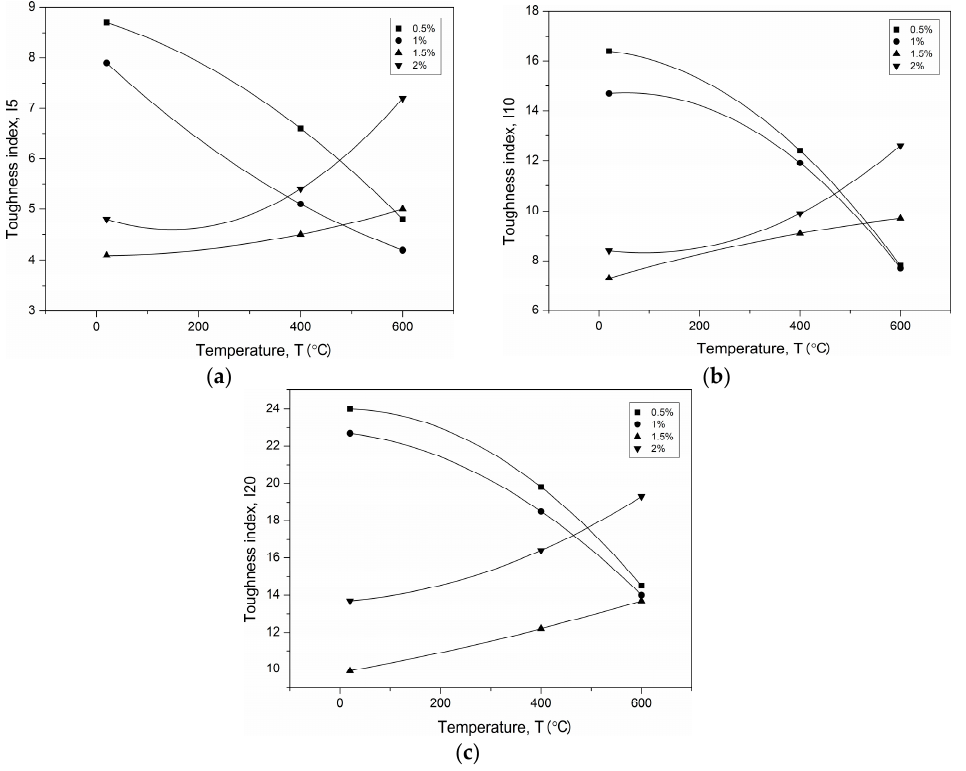
Figure 8. Temperature–toughness indexes fitted curves of PPF-reinforced UHPC ( a ) I5, ( b ) I10.